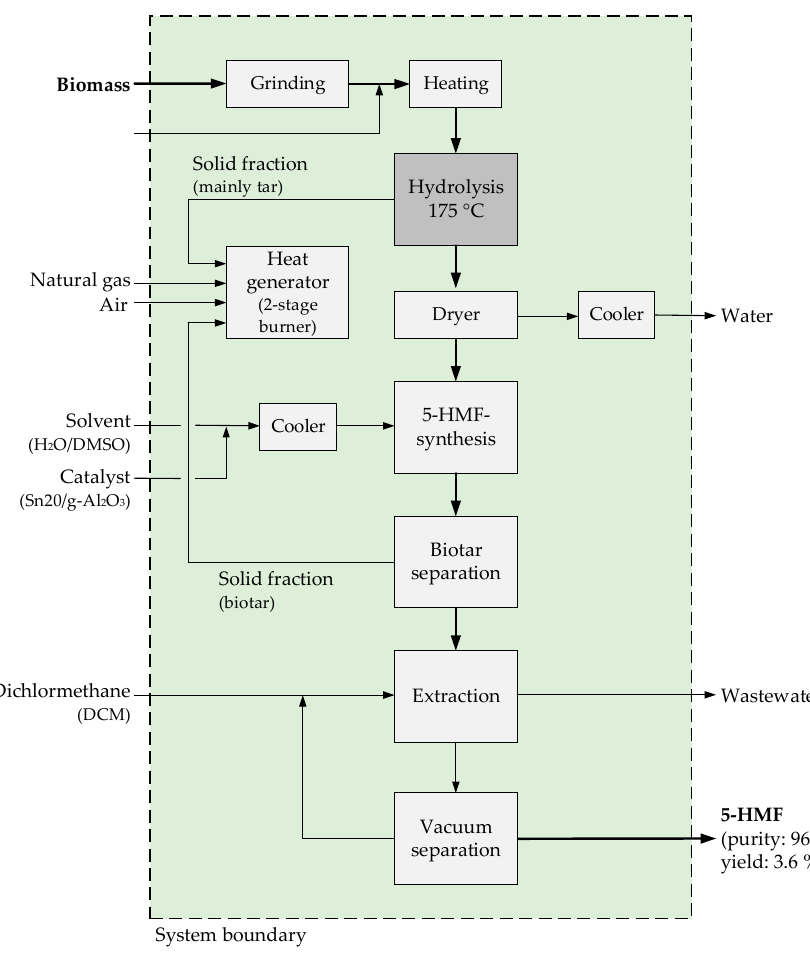
Figure 1. Production process of HMF (following the pilot process of the literature [15]).